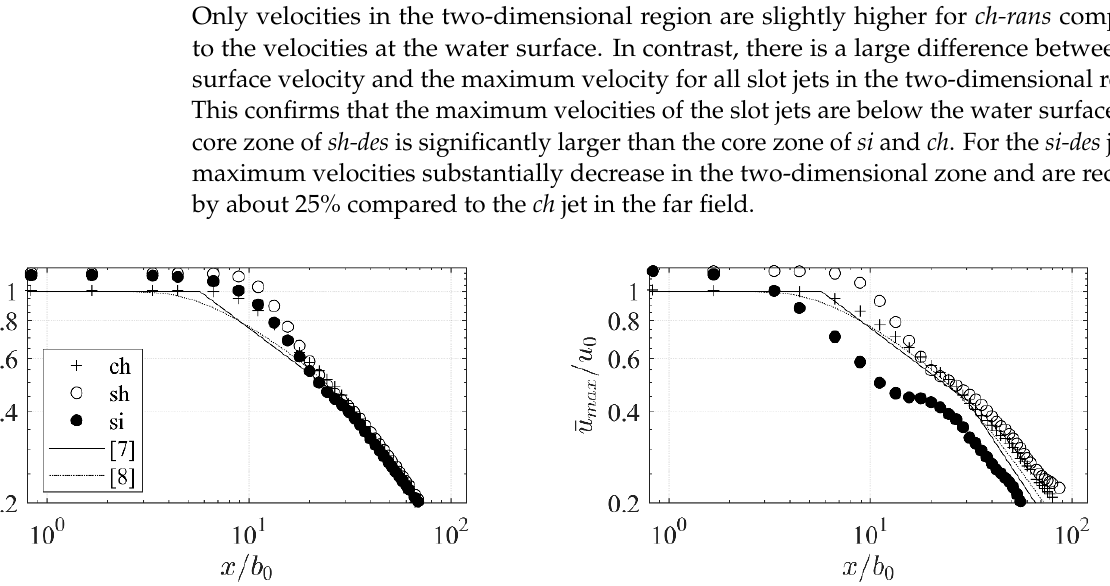
Figure 13. Downstream evolution of the mean streamwise centerline velocity u / u 0 at y = 0 and z = h 0 for ( a ) simulation with RANS (kw-SST turbulence model) ( b ) simulation with DES. Analytical models are given for comparison: [7,8].